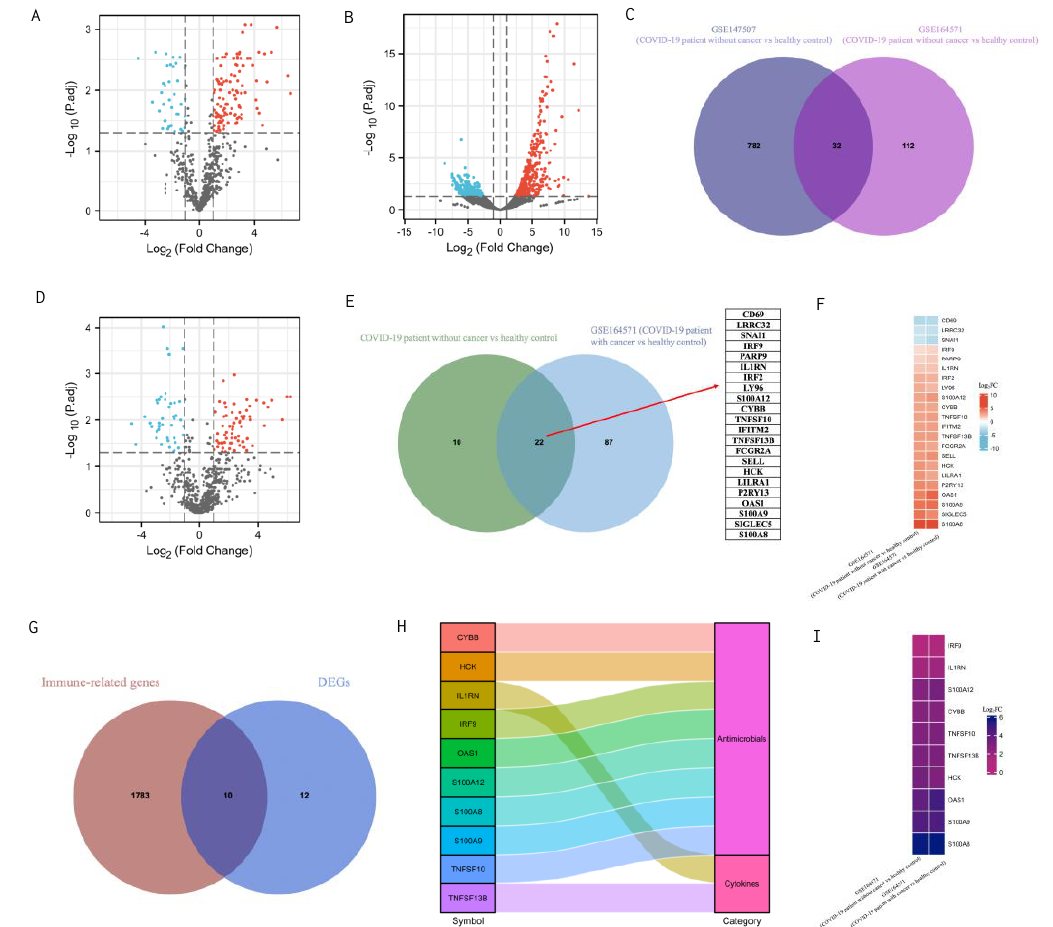
Figure 2. Identification of DEGs and screening of common DEGs between COVID-19 patients with and without cancer. The volcano plot depicts the DEGs between COVID-19 patients without cancer and healthy controls by using the GSE164571 ( A ) and GSE147507 ( B ) datasets (Adjusted p -value < 0.05, |log2FC| ≥ 1). Based on DEGs in ( A , B ), the common DEGs were shown through a Venn diagram ( C ). Identification of DEGs between COVID-19 patients with cancer and healthy control by using the GSE164571 dataset ( D ) (Adjusted p -value < 0.05, |log2FC| ≥ 1). The Venn diagram ( E ) shows the common DEGs between 32 common genes derived from ( C ) and DEGs derived from ( D ). ( F ) The heatmap shows gene expression changes in the following two groups of the common DEGs from ( E ) in the GSE164571 dataset: COVID-19 patient without cancer vs healthy control, COVID-19 patient with cancer vs healthy control. ( G ) The Venn diagram shows the common genes between 22 DEGs obtained from Figure 2E and immune-related genes. ( H ) The 10 immune-related genes obtained from Figure 2G were classified and visualized by a Sankey diagram. ( I ) Based on the GSE164571 dataset, the expression levels of 10 immune-related genes obtained from Figure 2G were visualized in different groupings by